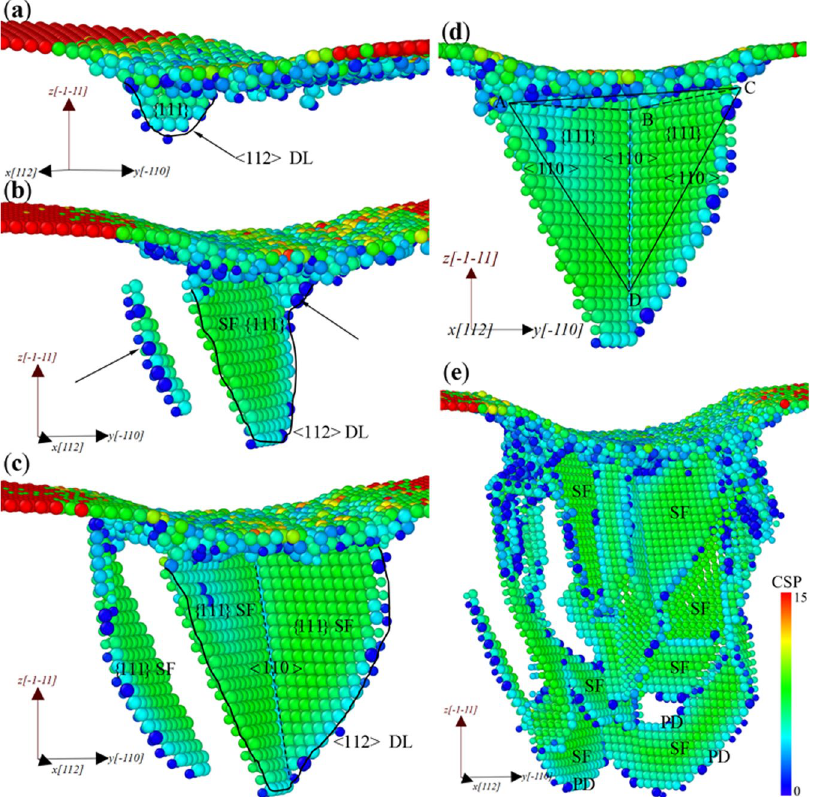
Figure 4. Microstructures of XSC, colored with CPS . ( a ) h = 5.76 Å, ( b ) h = 6.24 Å, ( c ) h = 6.72 Å, ( d ) h = 6.72 Å for illustration of formation mechanisms of a symmetrical structure formed in XSC and ( e ) h = 13.44 Å. Atoms with CSP < 0.5 and indenter atoms have been